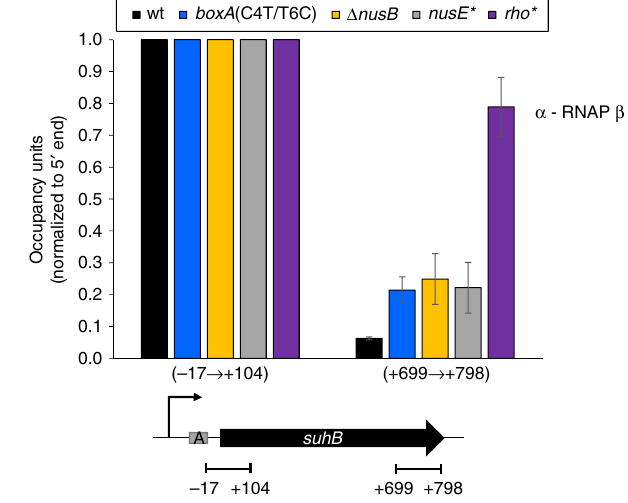
Fig. 1 Transcription termination within suhB is dependent on Rho and Nus factors. RNAP ( β ) enrichment at suhB 5 ′ and 3 ′ regions was measured using ChIP-qPCR in wild-type MG1655, boxA (C4T/T6C), Δ nusB , nusE (A12E) or rho (R66S) mutant strains. Values are normalized to signal at the 5 ′ end of suhB . x -axis labels indicate qPCR amplicon position relative to suhB . Error bars represent ± 1 standard deviation from the mean ( n = 3). A schematic depicting the suhB gene, the transcription start site (bent arrow) and boxA (grey rectangle) is shown below the graph. Horizontal black lines indicate the position of PCR